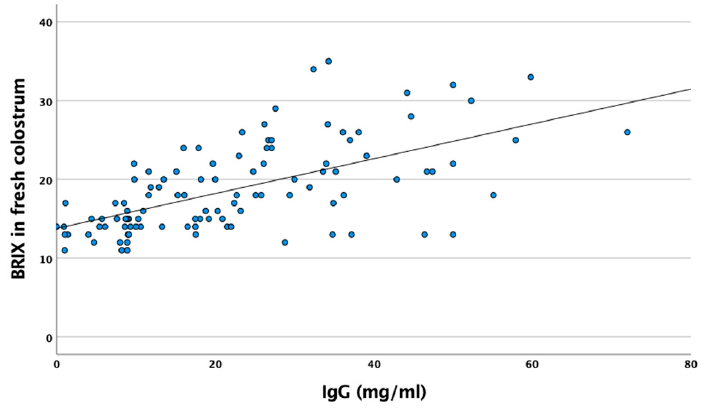
Figure 3. Relation between Brix value measured by optical refractometer and IgG concentration measured by ELISA in fresh colostrum.